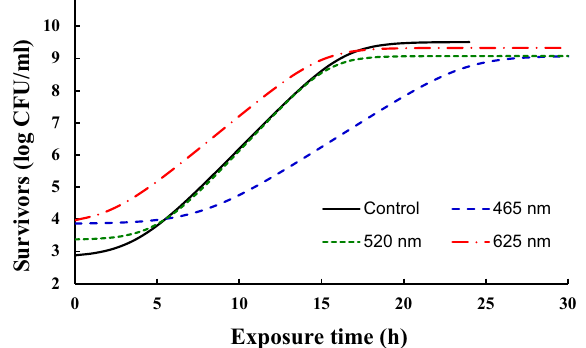
Figure 1. Growth survival of E. coli O157:H7 under the influence of different wavelengths light. Cells growth under dark condition was served as control.